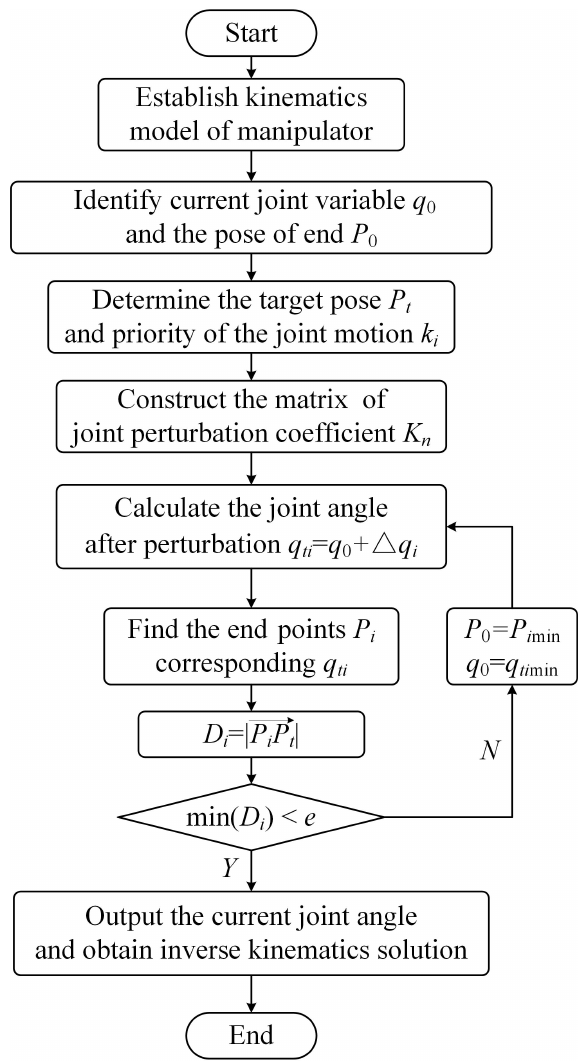
Figure 3. The flow chart of the algorithm based on joint perturba- tion.